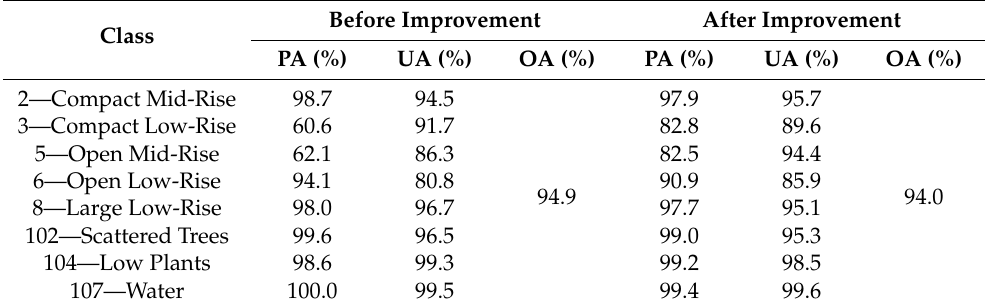
Table 3. Accuracies of the LCZ classification output, before and after classification